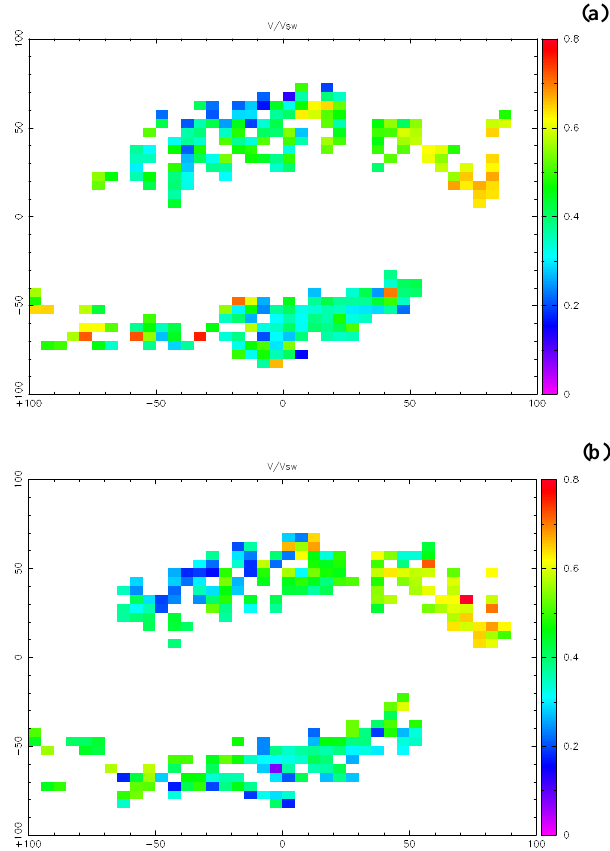
Fig. 9. Magnetosheath velocity ((a) and (b)) for IMF B y > 0 (a) and B y < 0 (b) . The spectrograms shown are for the radial cross section of the magnetosheath which lies closest to the magnetopause. An examination of (a) and (b) shows that both the B y > 0 and B y <